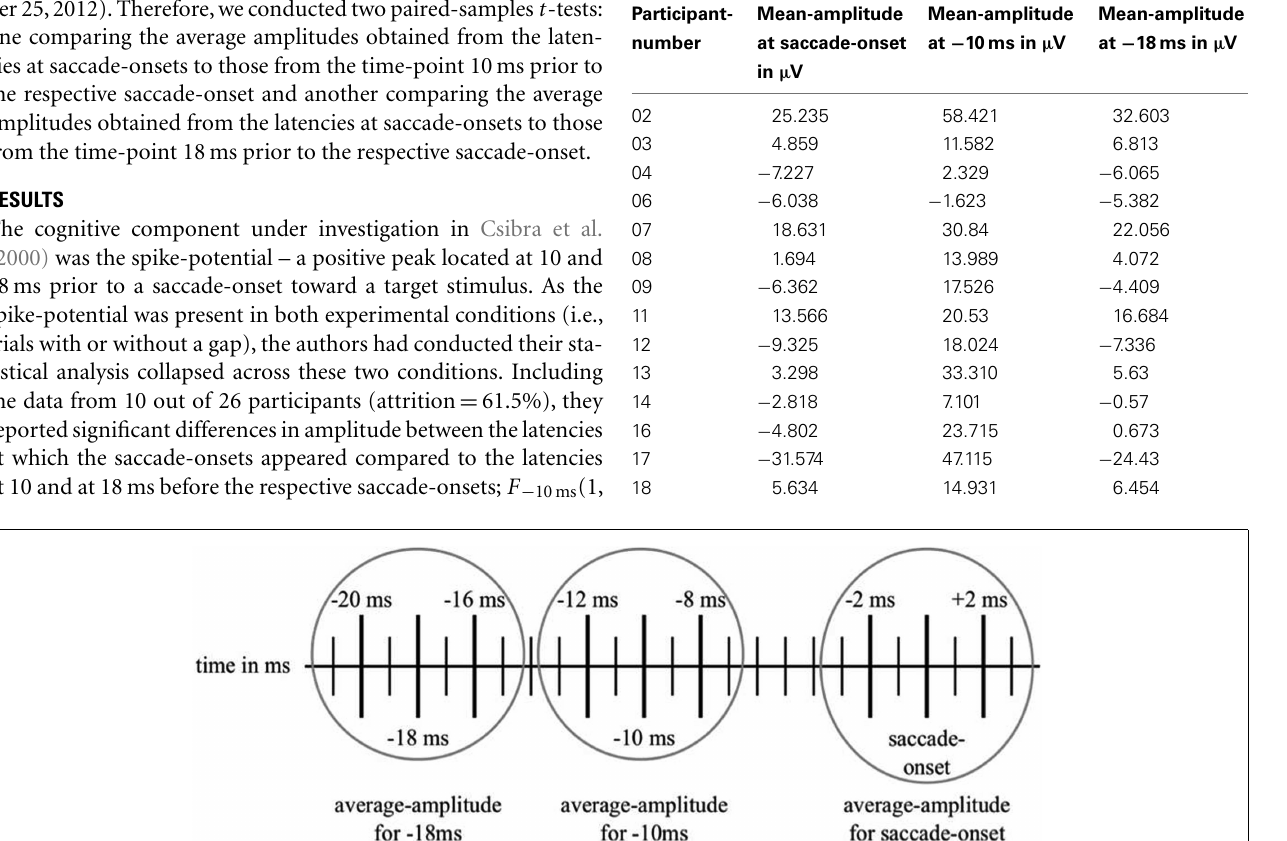
14 1-year-olds who contributed data to our analysis of the spike-potential in comparison to the time-points at − 10 and at − 18ms before saccade-onset.